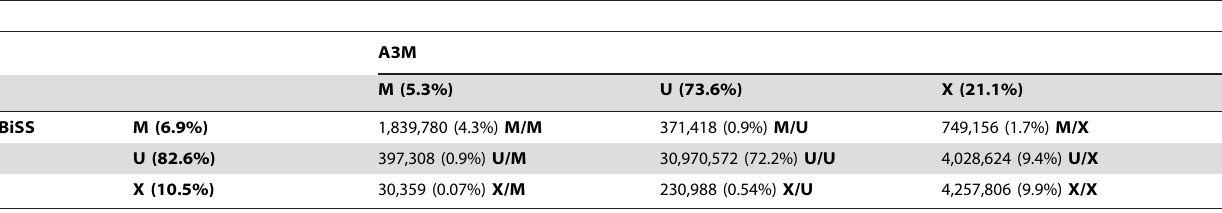
Table 2. Congruency between methylation calling by A3M and